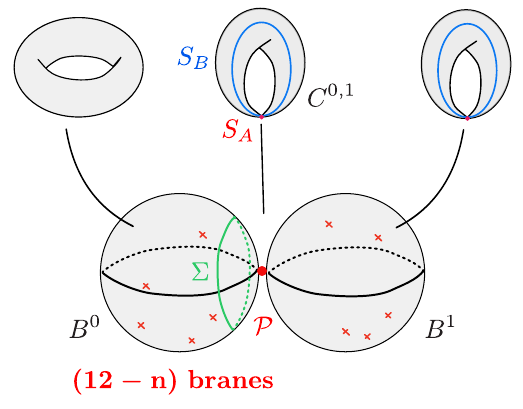
Figure 6 . Rational elliptic end component of a Kulikov Type III.a degeneration intersecting a neighbouring positive I component from the n